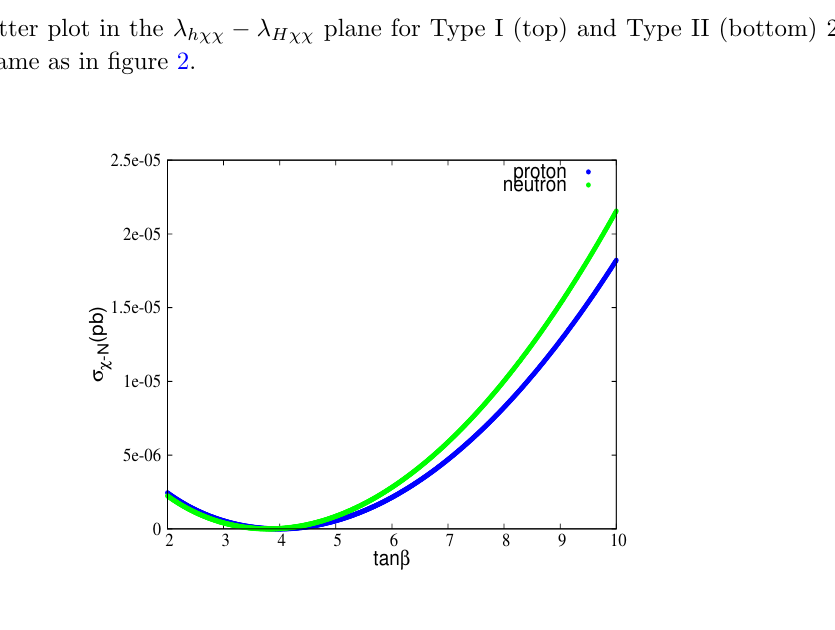
Figure 4 . χ N scattering cross section as a function of tan β with all other parameters fixed − as Type II BP I (table 2). Here N stands for nucleon type, namely, proton(blue curve) and neutron(green